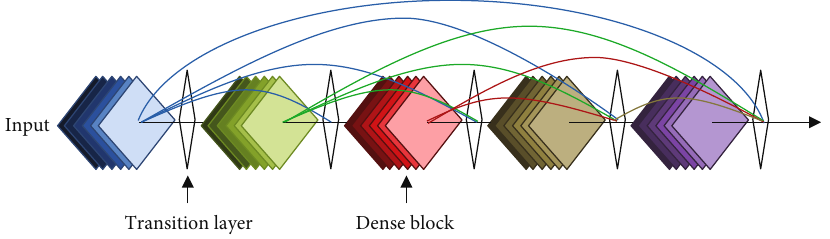
Figure 5: Dense connection mechanism of DenseNet. Table 1: Basic parameters of